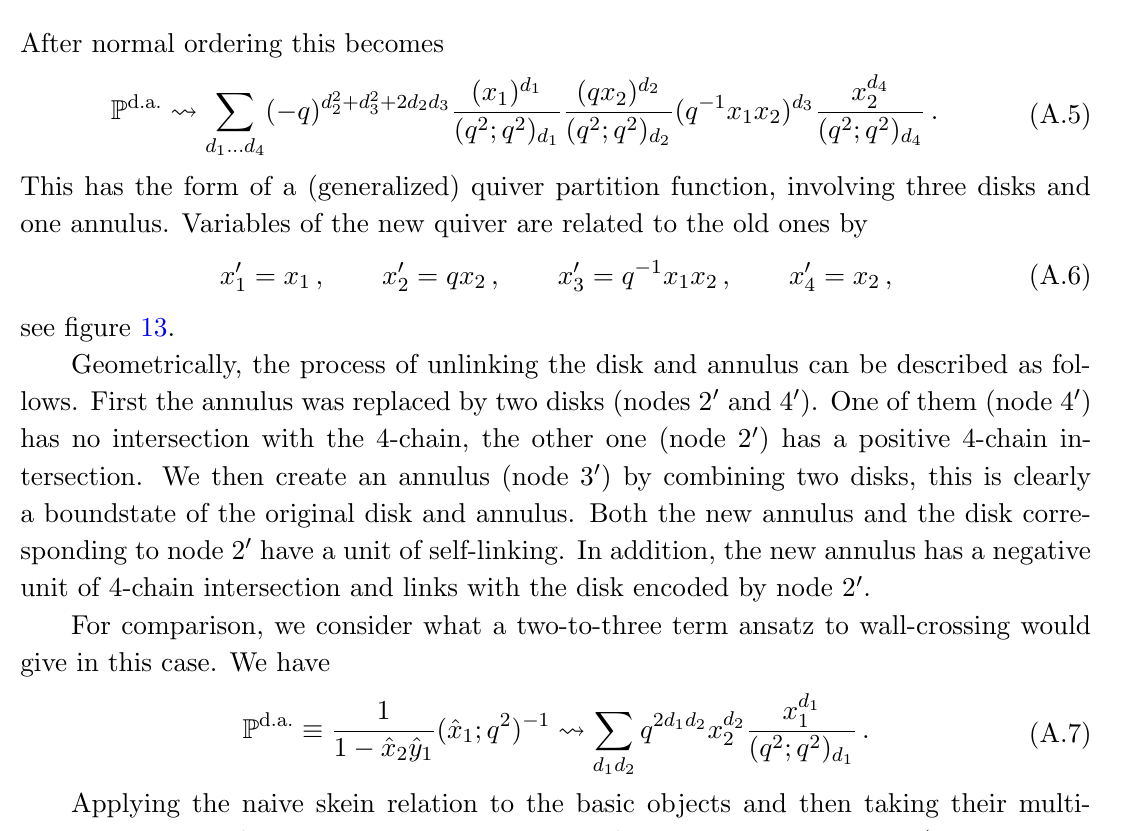
Figure 13. Disk-annulus multi-covering skein